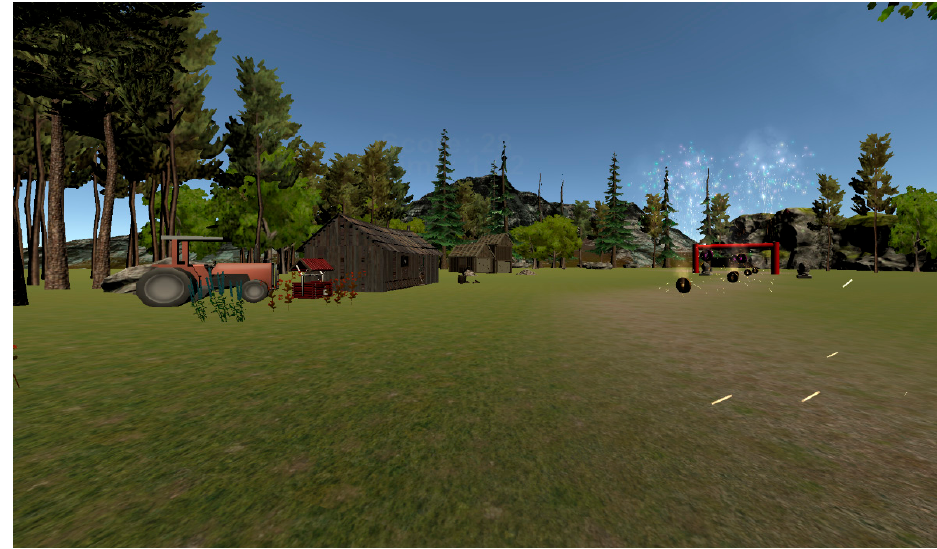
Figure 3. The village scene in the LA game without rest-frames. There is a visible red portal in the background that was needed to pass through to finish the game.